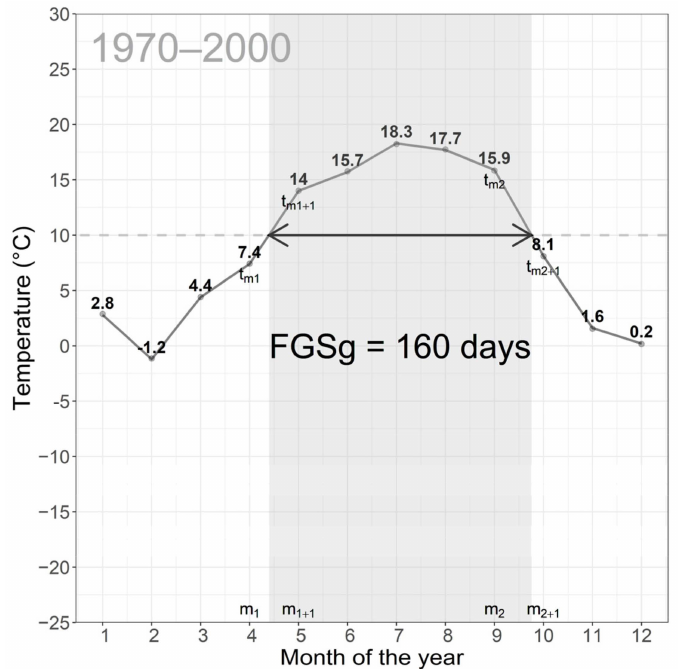
Figure 2. Graphical illustration of the method of determining the length of the ‘raw-grid’ forest growing season (FGSg) for the BIERU ´N STARY meteorological station on the basis of average monthly air temperature values for the period 1970–2000, obtained from the WorldClim grid